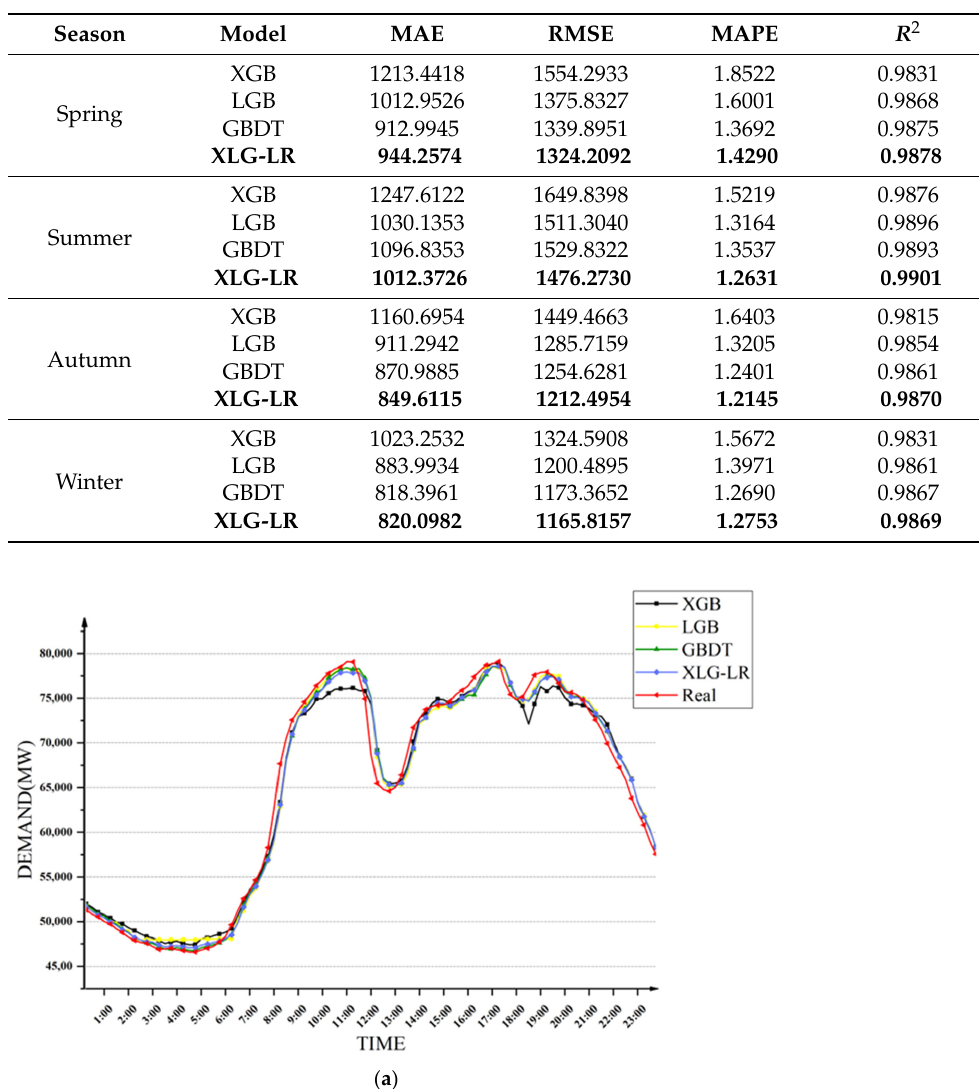
Table 3. Evaluation Index for Four-season Power Demand Forecasting of Each Model.